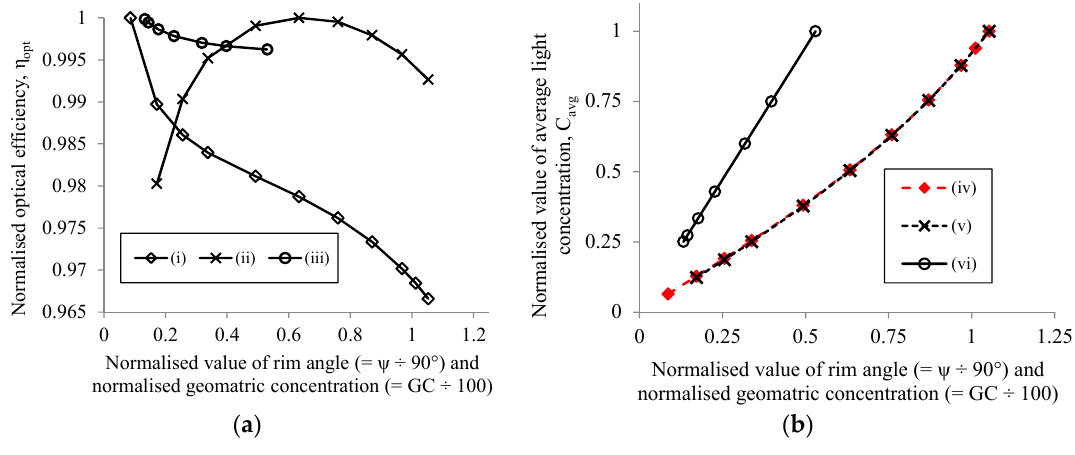
Figure 8. ( a ) Effect of, ( i ) rim angle for the receiver without glass envelop; ( ii ) rim angle for the receiver with glass envelop and ( iii ) GC on normalised η opt of a PTC; and ( b ) effect of, ( iv ) rim angle for the receiver without glass envelop; ( v ) rim angle for the receiver with glass envelop and ( vi ) GC on normalised C avg of a PTC. Table 2. Effect of design parameters on the uniformity of the LCR distribution around the receiver of a PTC. Variation of Mirror with Different Focal Length